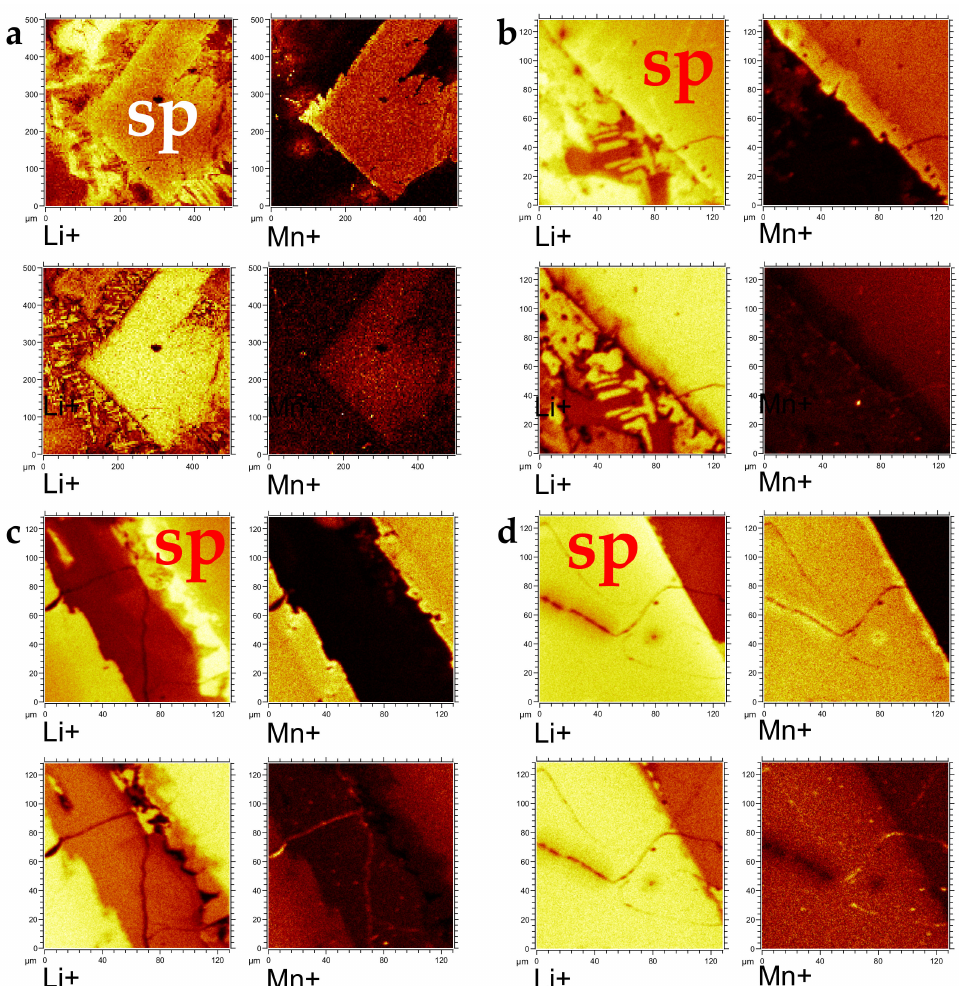
Figure 7. ( a – d ) Details of the lateral intensity distributions of selected positive isotope-resolved secondary ion signals of spinel (ss) grains (sp) depicting the relation of Li, Al, Mn (and